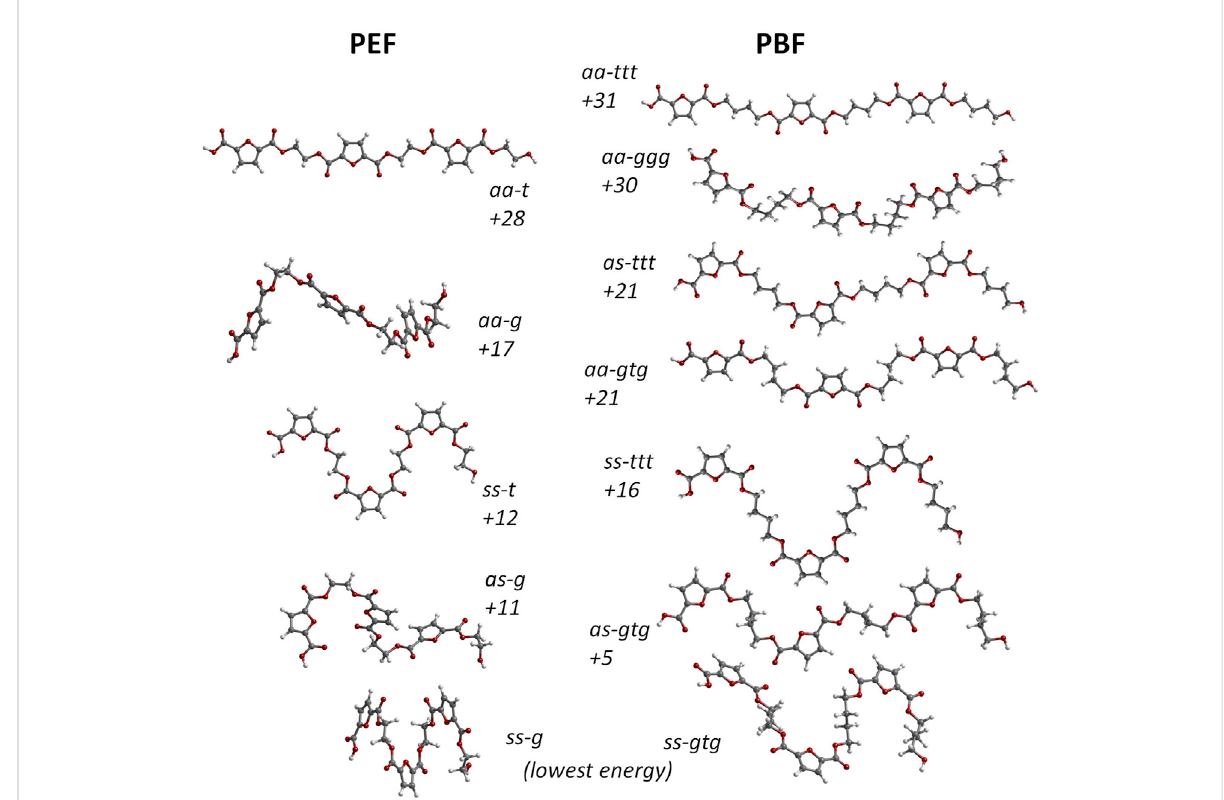
FIGURE 2 Comparison betweenthemolecularstructureofPBFtriadsBG 3 FDCA 3 (right)andPEFtriadsEG 3 FDCA 3 (left).Thenumbersindicatetheirrelative stability expressed in terms of electronic energy, at the B3LYP/6311G (d, p ) level, in kJ/mol. The aa , as and ss labels indicate the anti- and syn- orientation of the carbonyl bonds relative to nearest ring C=C bond in each FDCA fragment; for PBF, ttt and gtg indicate trans- and gauche- conformations along the BG skeleton. The as structures with alternate sequence as-sa-as for the three FDCA fragments present marginally lower energy than structures with as-as-as sequence and are used in this fi gure. Only the three ttt forms present a fully planar